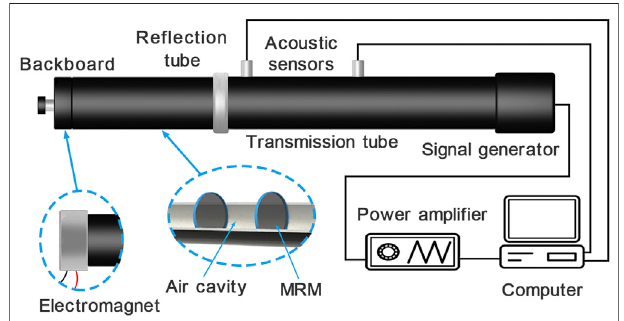
FIGURE 2 | Schematic diagram of the acoustic